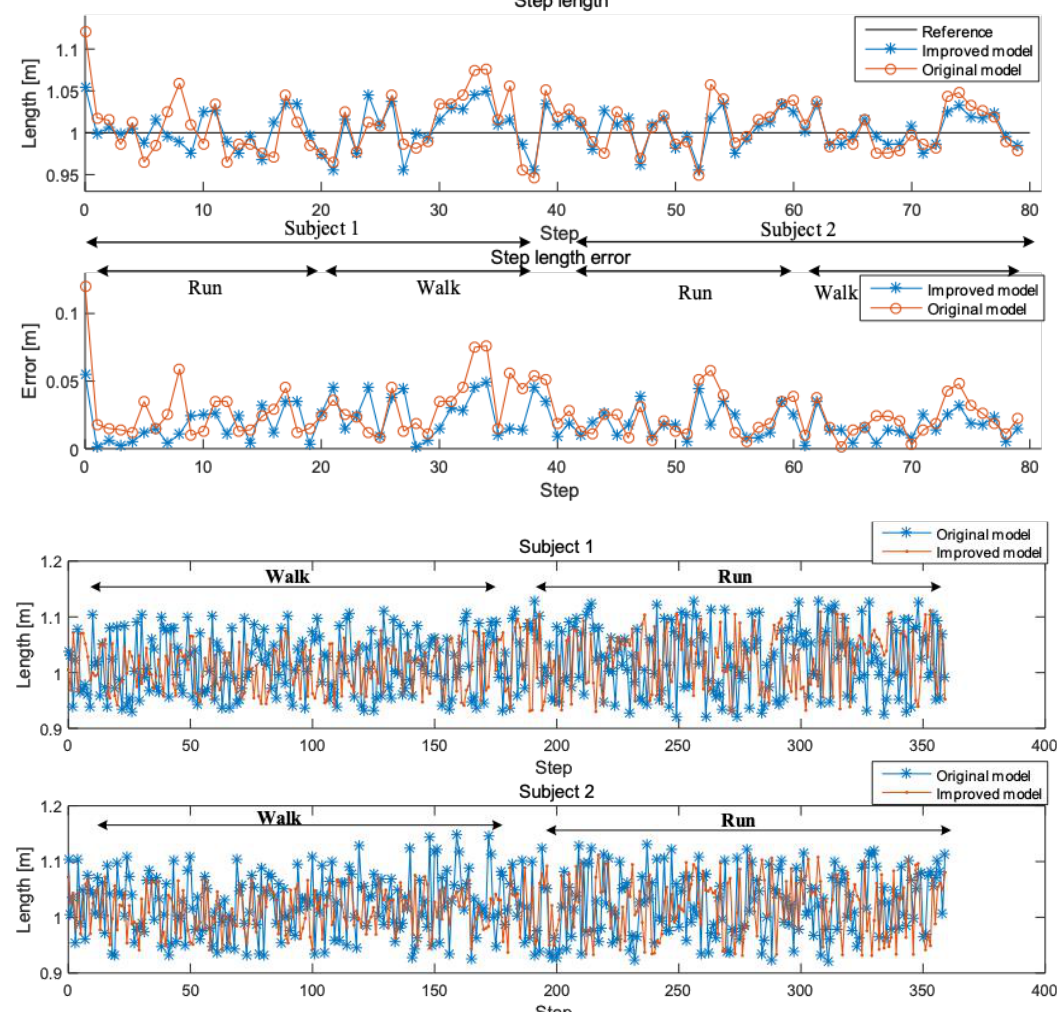
Figure 8. Step length and error comparison of two subjects in different motions using different models.